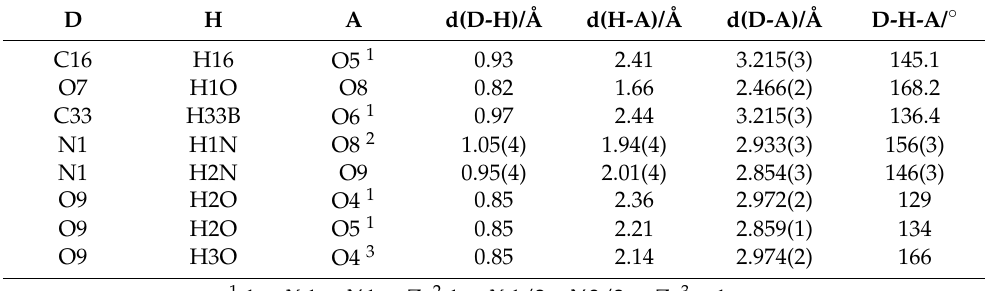
Table 4. Hydrogen Bonds detail for 4 .